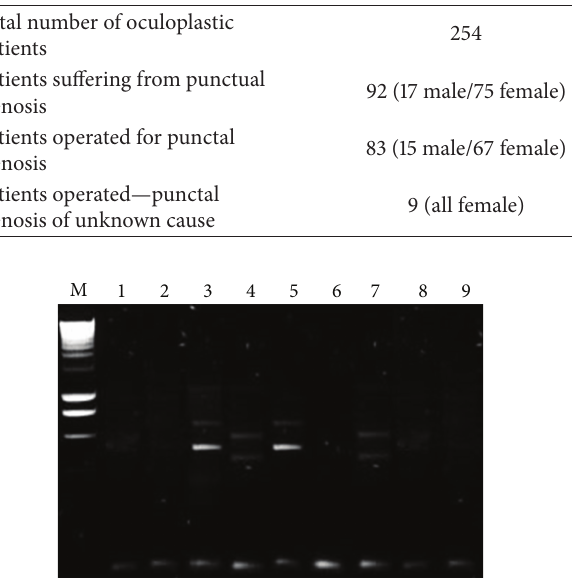
Table 4: Sequences of